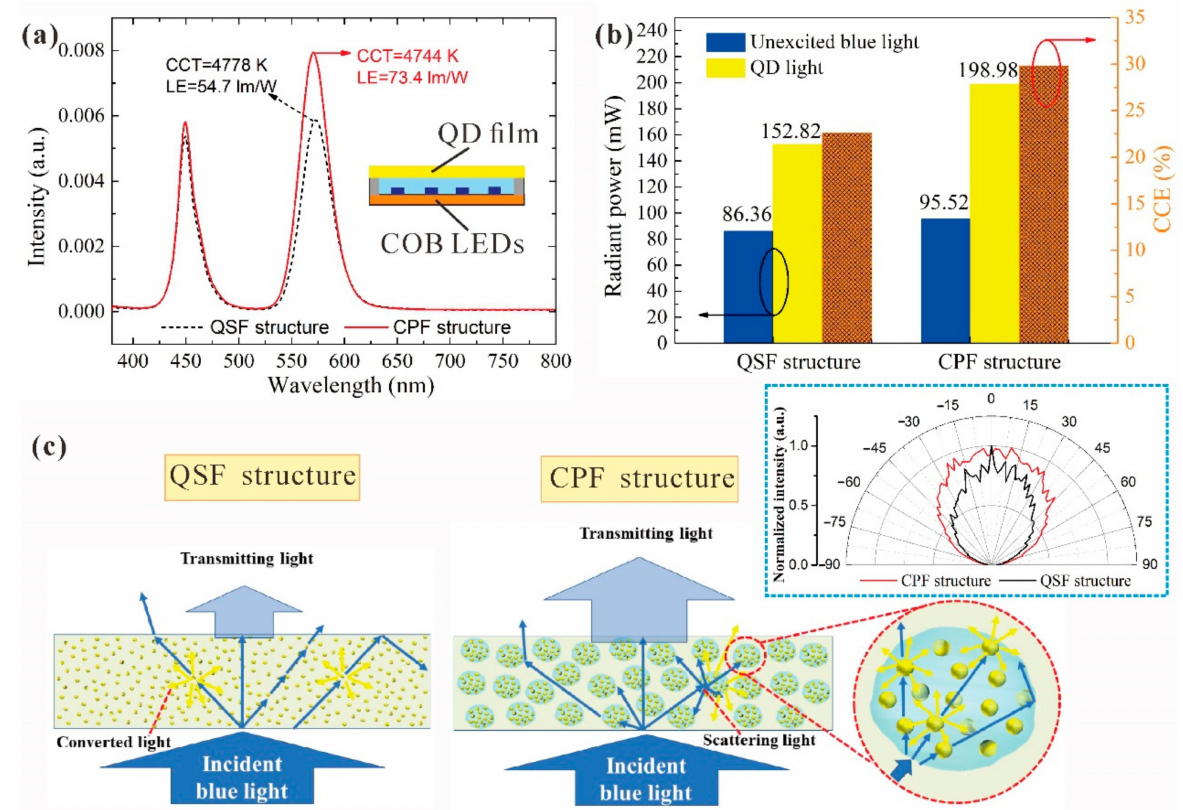
Figure 4. ( a ) Spectrum of devices with CPF structure and QSF structure under similar CCT at a driving current of 150 mA. The inset is the illustration of COB-LED device structure. ( b ) Radiant power of blue and QD light. ( c ) Schematics of light conversion and extraction for different structural films. The inset is the BTDF of two types of films under the same lighting